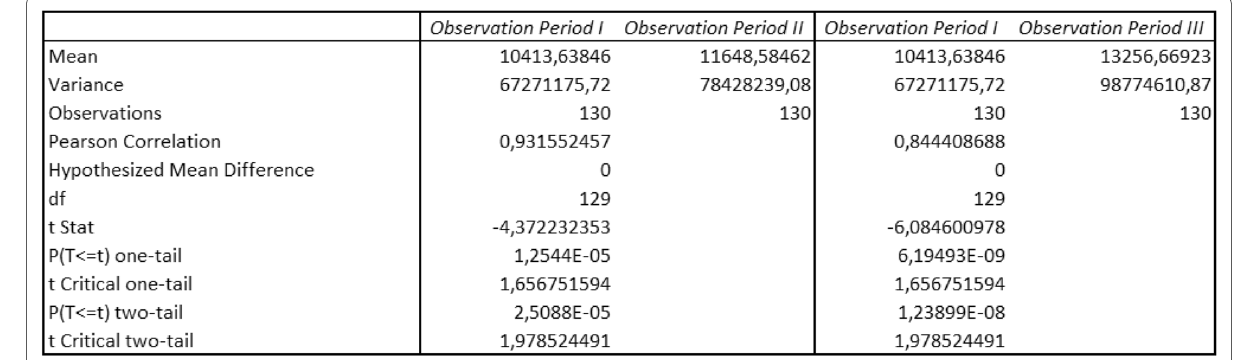
Fig. 1 t-Test Results of a Paired Two Sample for Means—Number of Words of the NFS